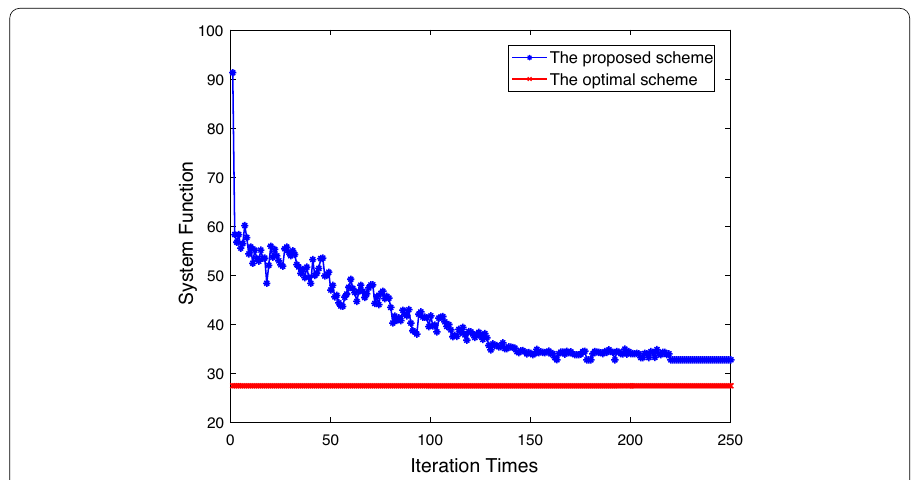
Fig. 5 The system function comparison between the proposed scheme and the optimal scheme versus iteration times (notably, the iteration times here refers to the serial number of the second layer of loop in Algorithm